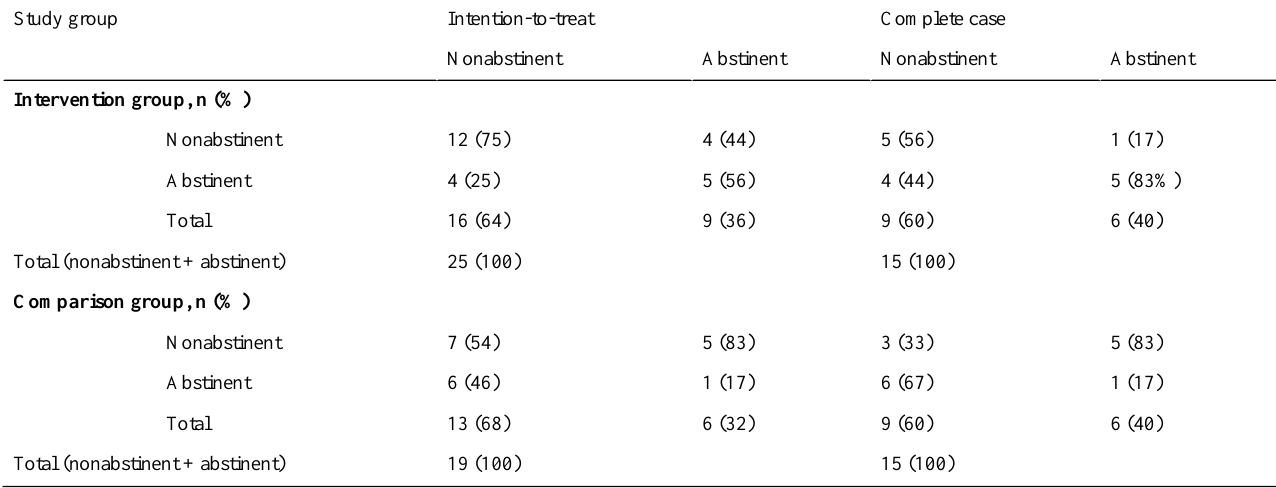
Complete caseIntention-to-treatStudy group